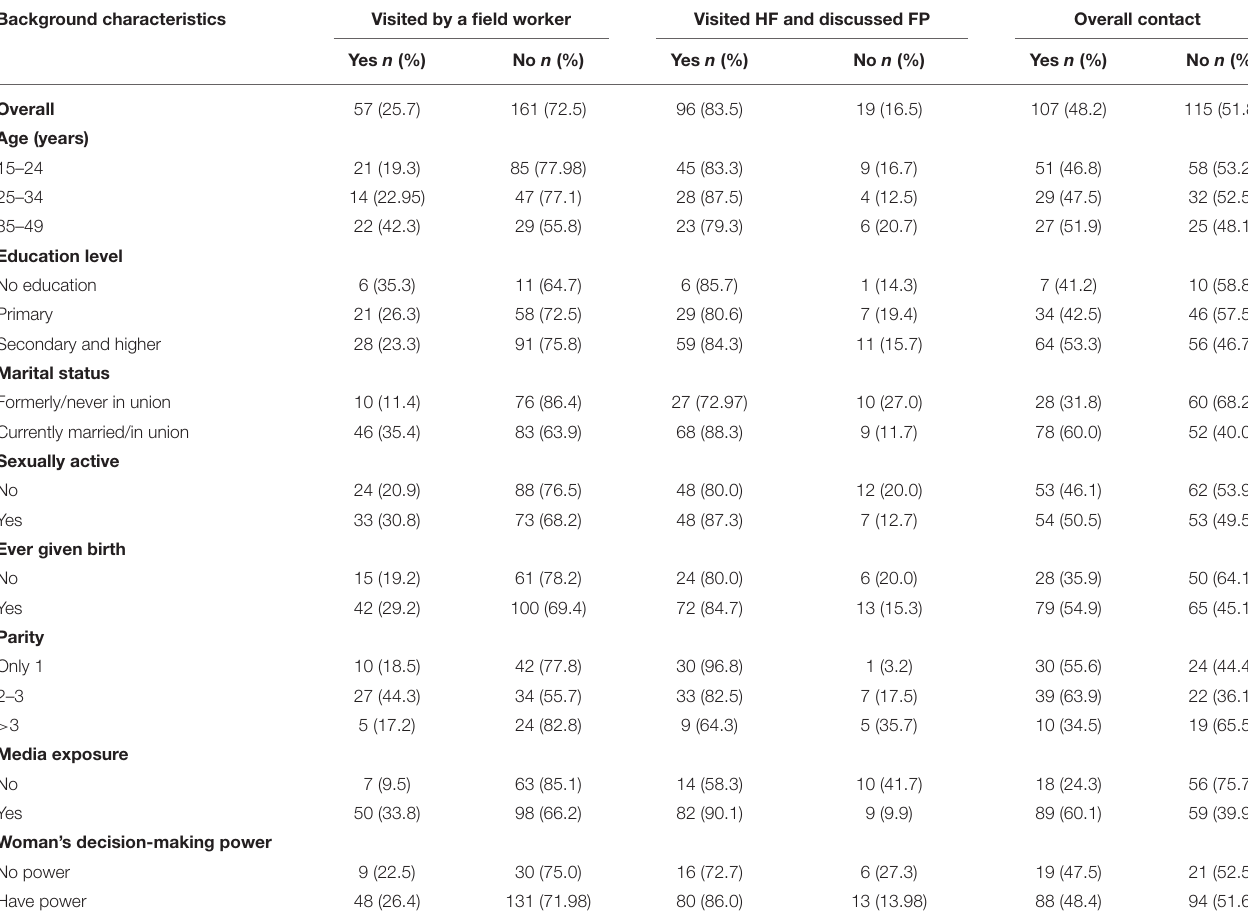
TABLE 4 | Contact of non-users of contraception with FPg providers by respondent